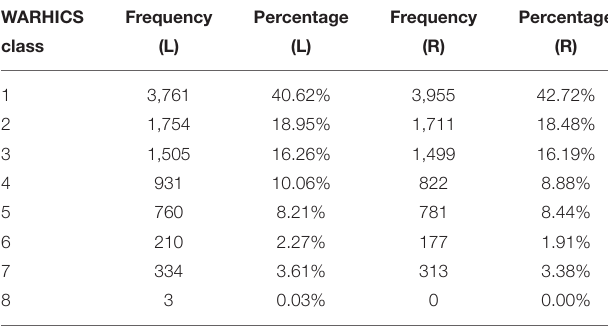
TABLE 1 | Distribution of WARHICS classes in left and right ears.